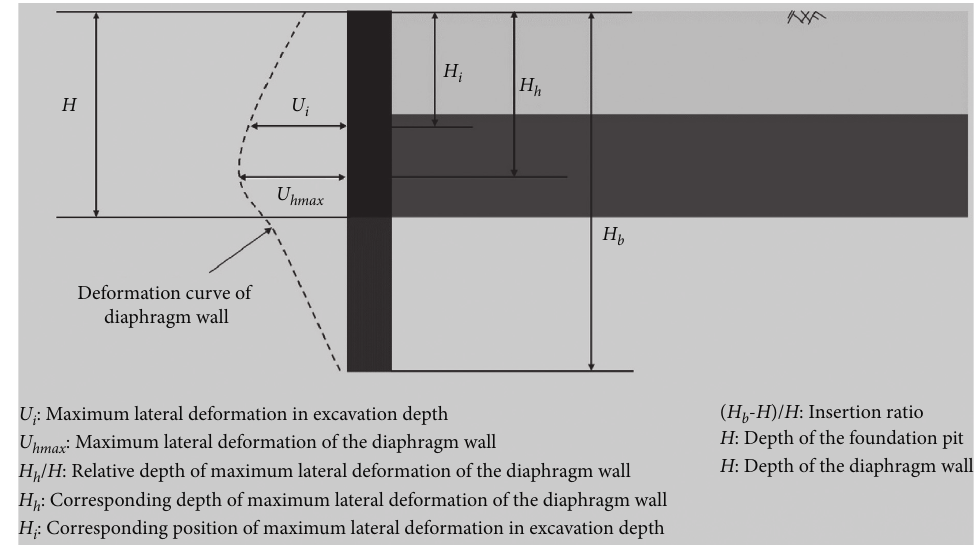
Figure 2: Variable symbols of the foundation pit and their